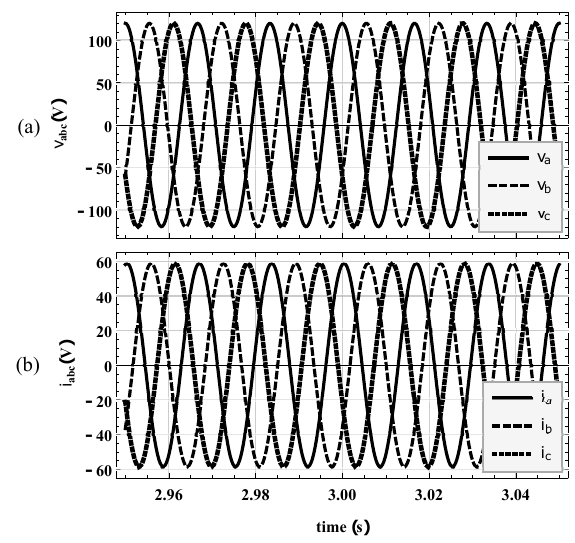
Figure 4. Load three-phase ac ( a ) voltage, and ( b )